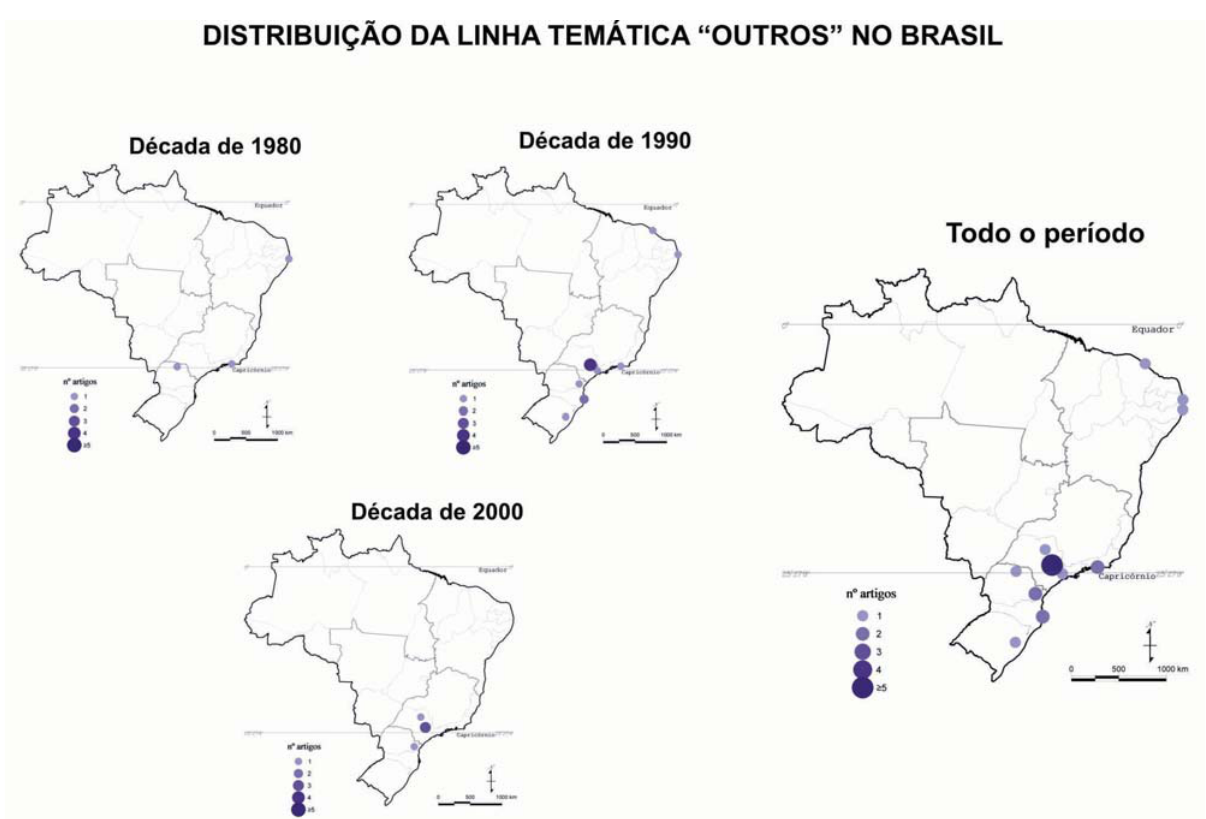
5. Distribuição espacial da produção de artigos na linha temática “OUTROS” por